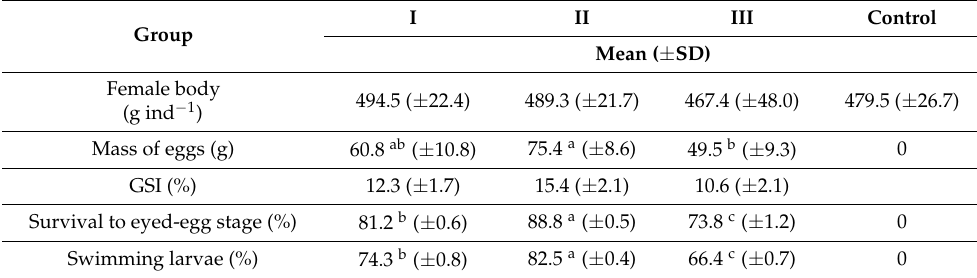
Table 4. Influence of different hormonal agents on egg quantity and quality during Ballerus ballerus (L.) artificial reproduction. The data in row with the same letter superscript are not differ statistically ( p >